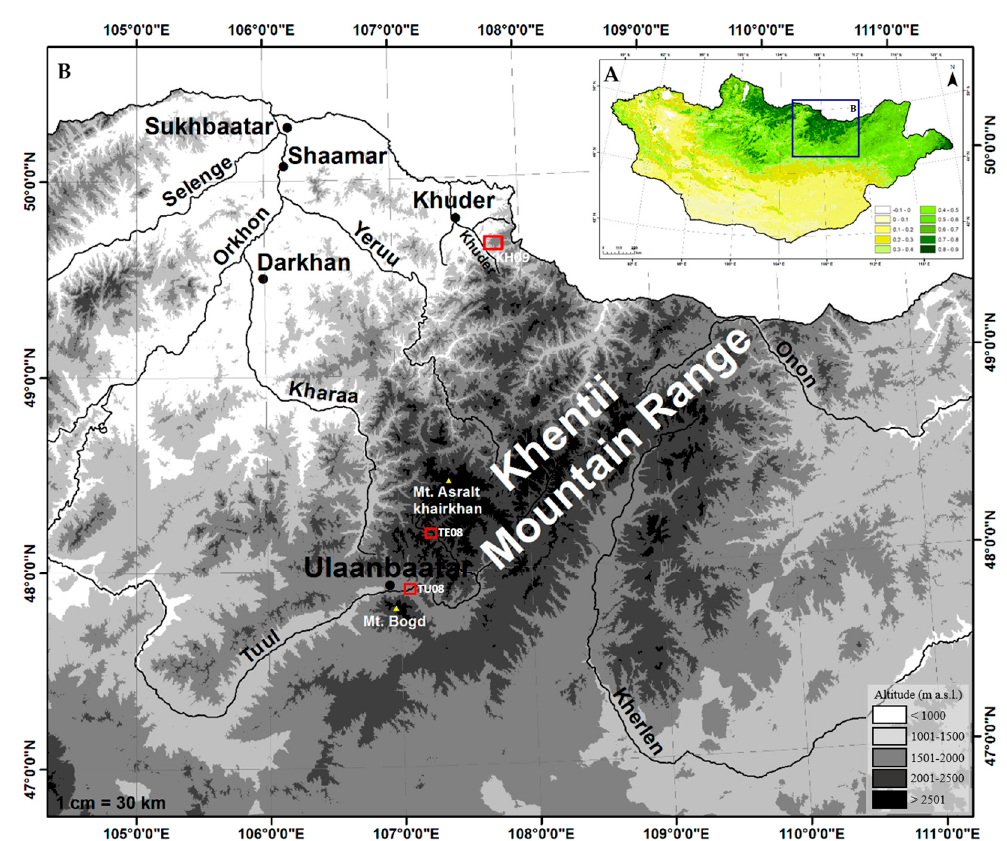
Figure 1. ( A ) The normalized difference vegetation index (NDVI) of Mongolia in 2015. Modified from Orkhonselenge et al. [22]. The box indicates the location of Khentii Mountain Range. ( B ) Physiography of Khentii Mountain Range with locations of coring sites in Terelj River (TE08), Tuul River (TU08) and Khuder River (KH09) drainage basins. Modified from Orkhonselenge and Uuganzaya [23]. Results from the core KH09 were published in Fukumoto et al. [16].